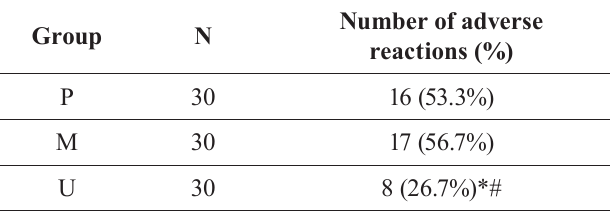
TABLE III - Comparison of incidence of adverse effects Number of adverse Group N